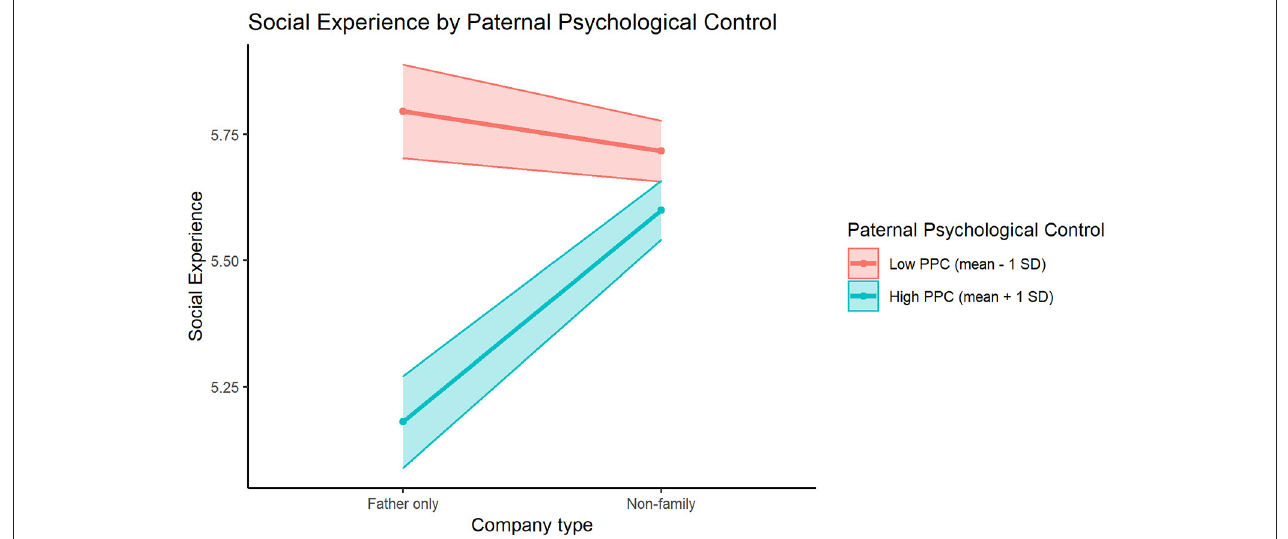
FIGURE 3 | The significant interaction effect between PPC (Paternal Psychological Control) and paternal vs. non-family company in the prediction of mean social experience, for participants ± 1 standard deviation of the Paternal Psychological Control mean